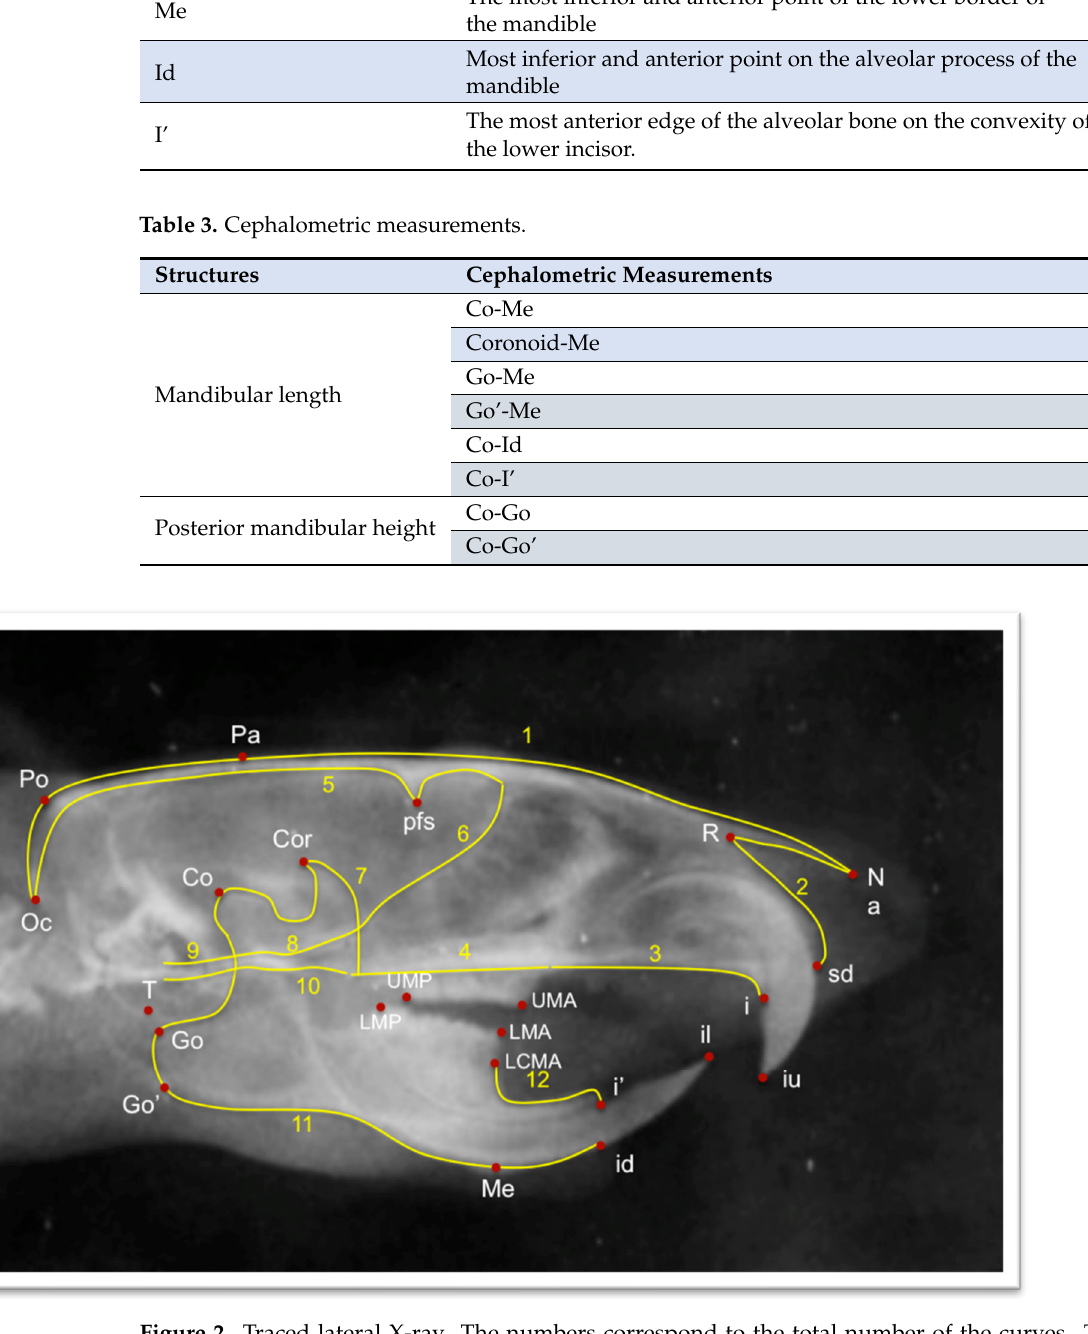
Figure 2. Traced lateral X-ray. The numbers correspond to the total number of the curves. The cephalometric landmarks correspond to Table 2. Table 2. Cephalometric landmarks.